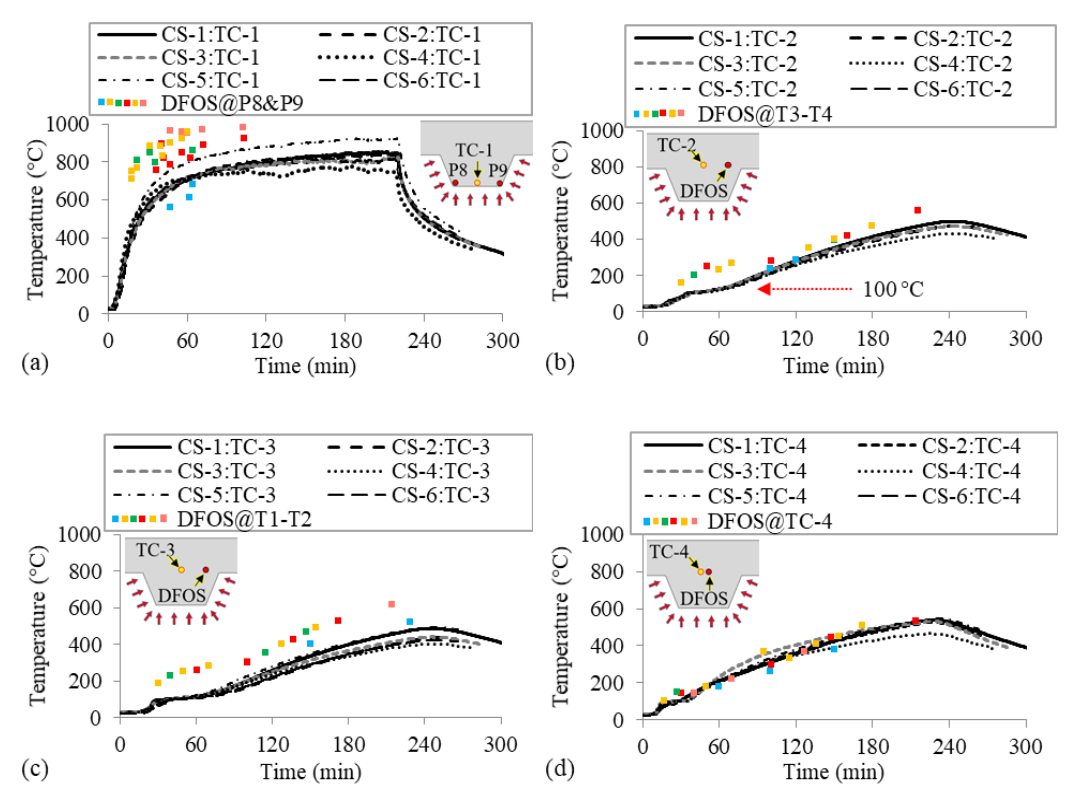
Figure 10. Temperature histories in the tested specimens using: ( a ) TC-1, ( b ) TC-2, ( c ) TC-3, and ( d ) TC-4. The illustrations depict the positions of the thermocouple and distributed sensors.